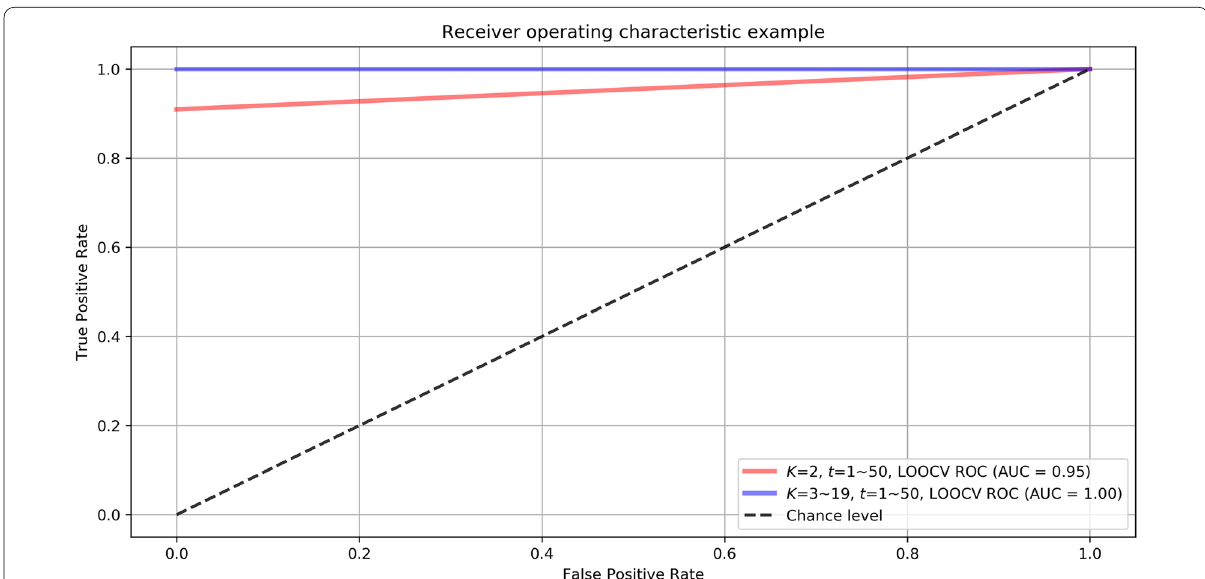
Fig. 3 Receiver operating characteristic (ROC) curve of the SNF fused similarity networks with different levels and combinations of the K and